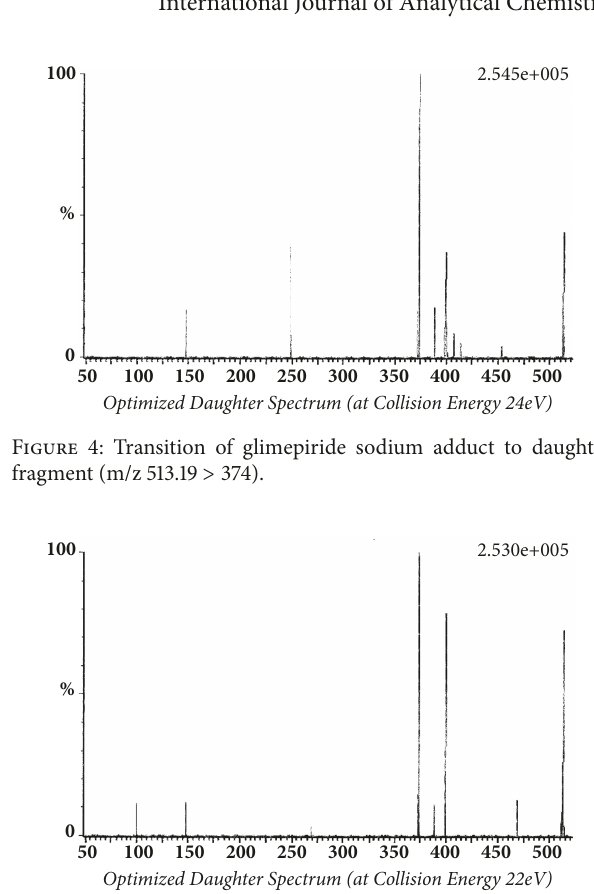
Figure 5: Transition of glimepiride sodium adduct to daughter fragment (m/z 513.19 >